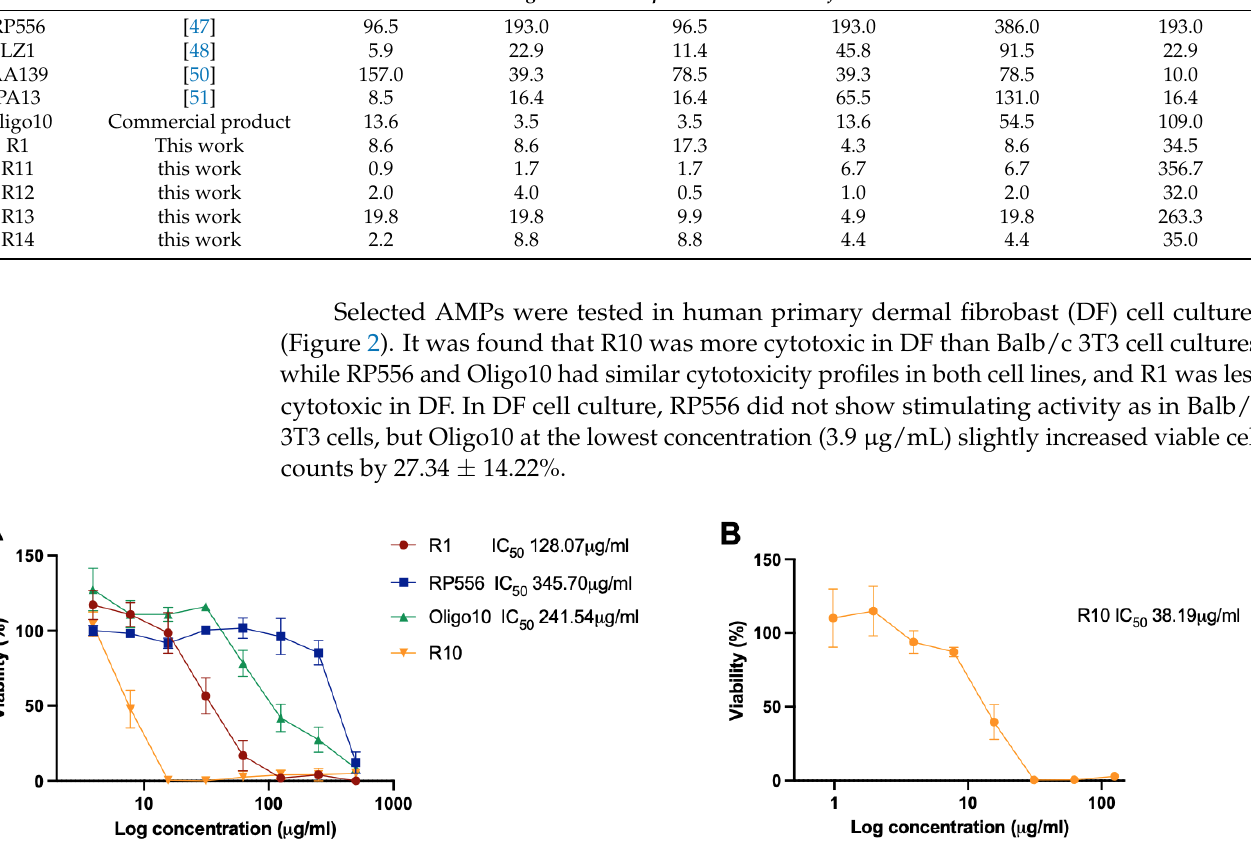
Figure 2. Viability of human primary dermal fibroblasts after incubation with antimicrobial peptides. ( A )—peptides R1, RP556, Oligo10, and R10 at concentration range 3.9–500 µ g/mL), ( B )—peptide R10 at concentration range 0.98–125 µ g/mL). Viability expressed as %, compared to control, n =